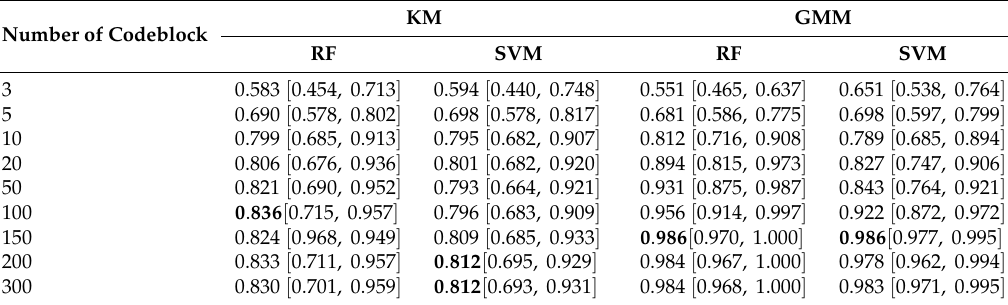
Table 3. Area under the ROC curve (AUC) comparison among different numbers of